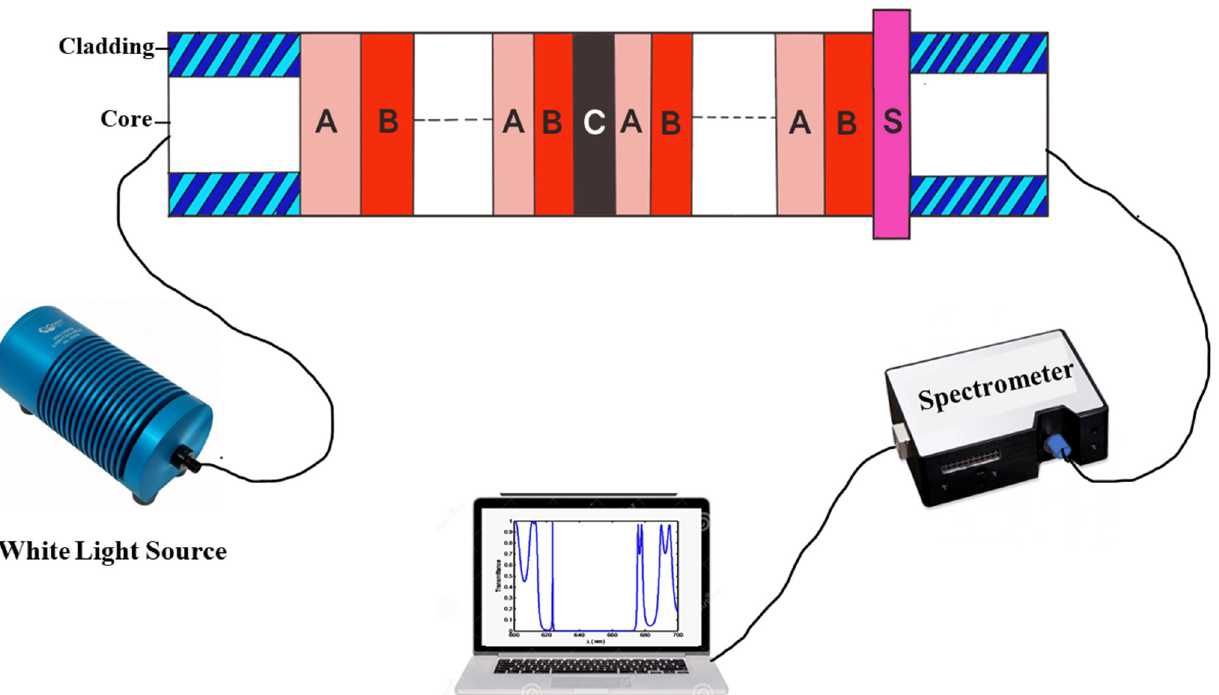
Figure 4. Experimental setup is required for the measurement of transmission response of the biosensor. Here, letters A, B and C represent silicon, lanthanum flint and air layers of the structure fabricated on the glass substrate S.